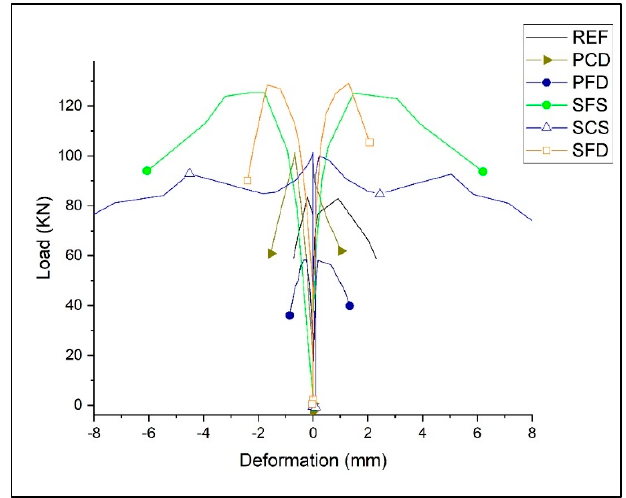
Figure 14. Load–deformation backbone curves of reference and strengthened specimens.